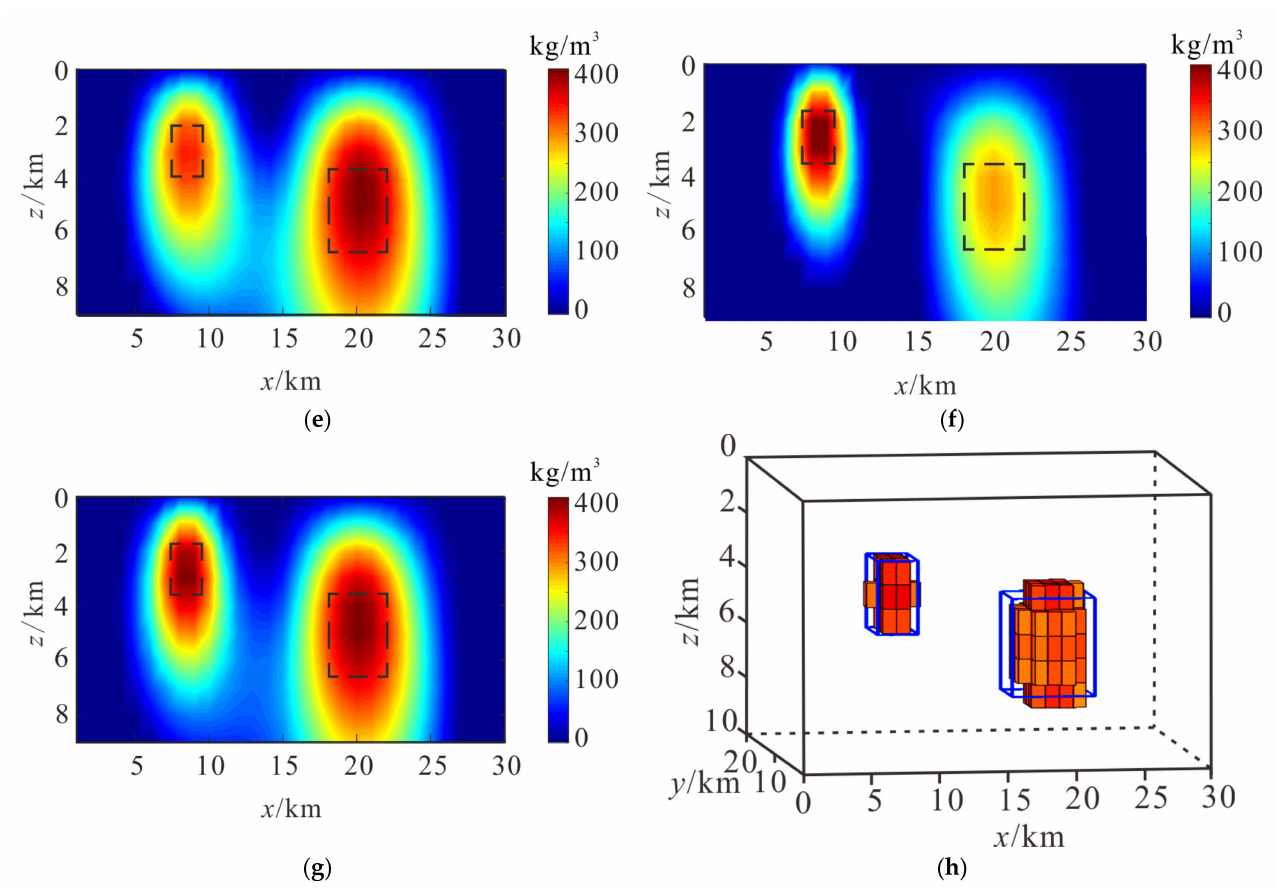
Figure 3. Model tests of two prisms in different depths. ( a ) Density slice (y = 10 km) by Tikhonov regularized method of airborne gravity data. ( b ) Density slice (y = 10 km) by Tikhonov regularized method of airborne gravity gradient data. ( c ) Density slice (y = 10 km) by data combined joint inversion method of airborne gravity and its gradient data. ( d ) 3D density distribution (larger than 350 kg/m 3 ) by data combined joint inversion method of airborne gravity and its gradient data. ( e ) Density slice (y = 10 km) by structure constrained joint inversion method of airborne gravity data. ( f ) Density slice (y = 10 km) by structure constrained joint inversion method of airborne gravity gradient data. ( g ) Density slice (y = 10 km) by cooperate density-integrated inversion method. ( h ) 3D density distribution (larger than 350 kg/m 3 ) by the cooperate density-integrated inversion method.